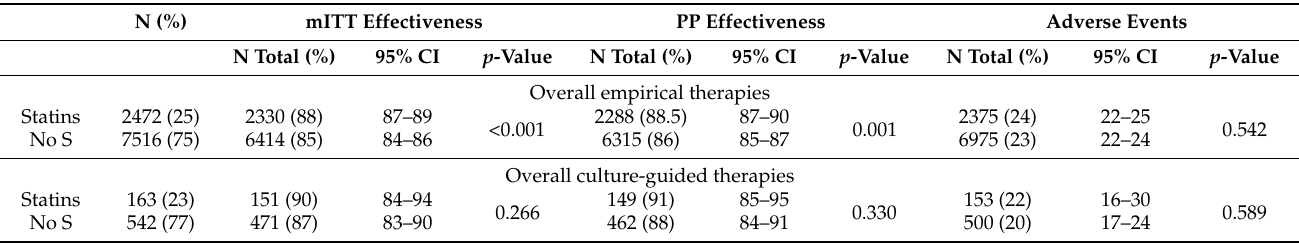
Table 3. Univariate analysis of effectiveness and safety according to the type of prescription (empirical versus culture-guided).